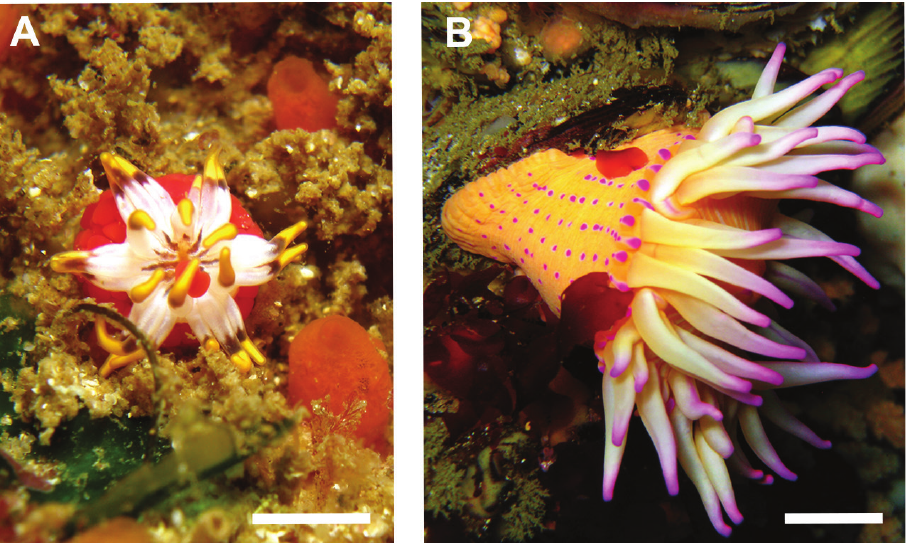
Figure 3. The two new species of sea anemone reported in this study: A Halianthella sp. n. (3 mm) and B Anthostella sp. n. (10 mm). Photographs taken by Guido Zsilavecz ( A ) and Megan Laird ( B